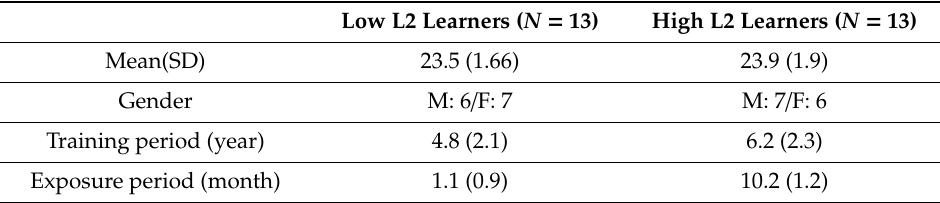
Table 1. Demographic information of the study subjects.